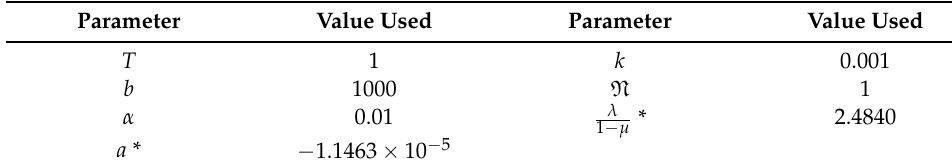
Table 5. Acquisition parameters for Apple stock.